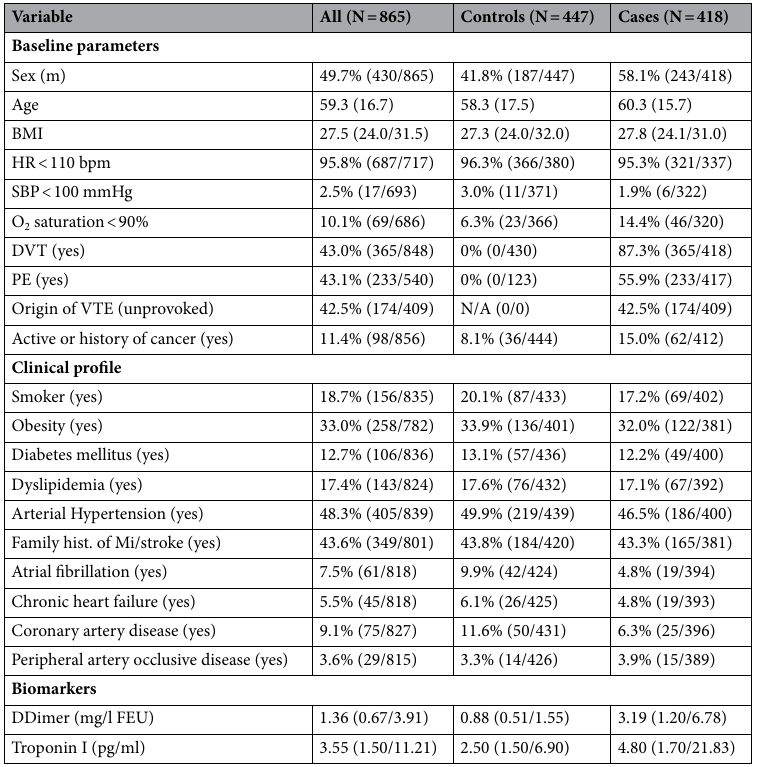
Table 1. Baseline characteristics of the patients. BMI body mass index, HR heart rate, SBP systolic blood pressure, DVT deep vein thrombosis, PE pulmonary embolism, VTE venous